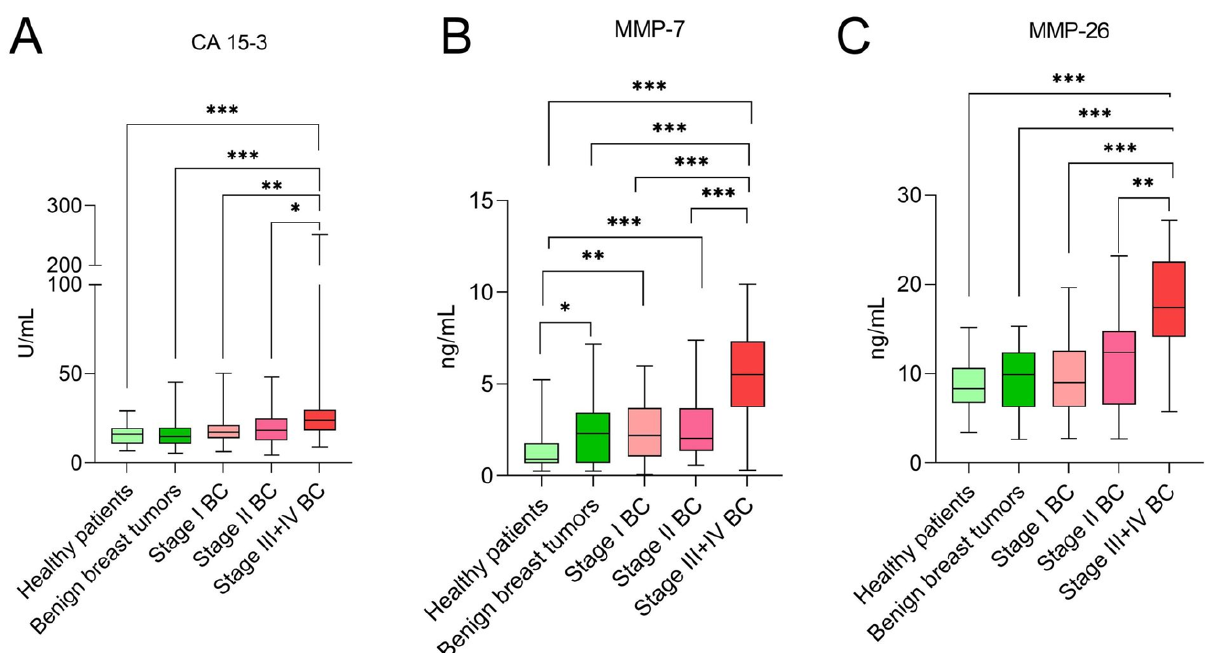
Figure 1. Plasma levels of tested parameters: CA 15-3 ( A ), MMP-7 ( B ) and MMP-26 ( C ) in patients with BC, benign breast tumour and healthy patients. Asterisks indicate significant differences (*, p < 0.05; **, p < 0.01; ***, p < 0.001). BC, breast cancer; CA 15-3, cancer antigen 15-3; MMP-7, matrix metalloproteinase 7; MMP-26, matrix metalloproteinase 26.